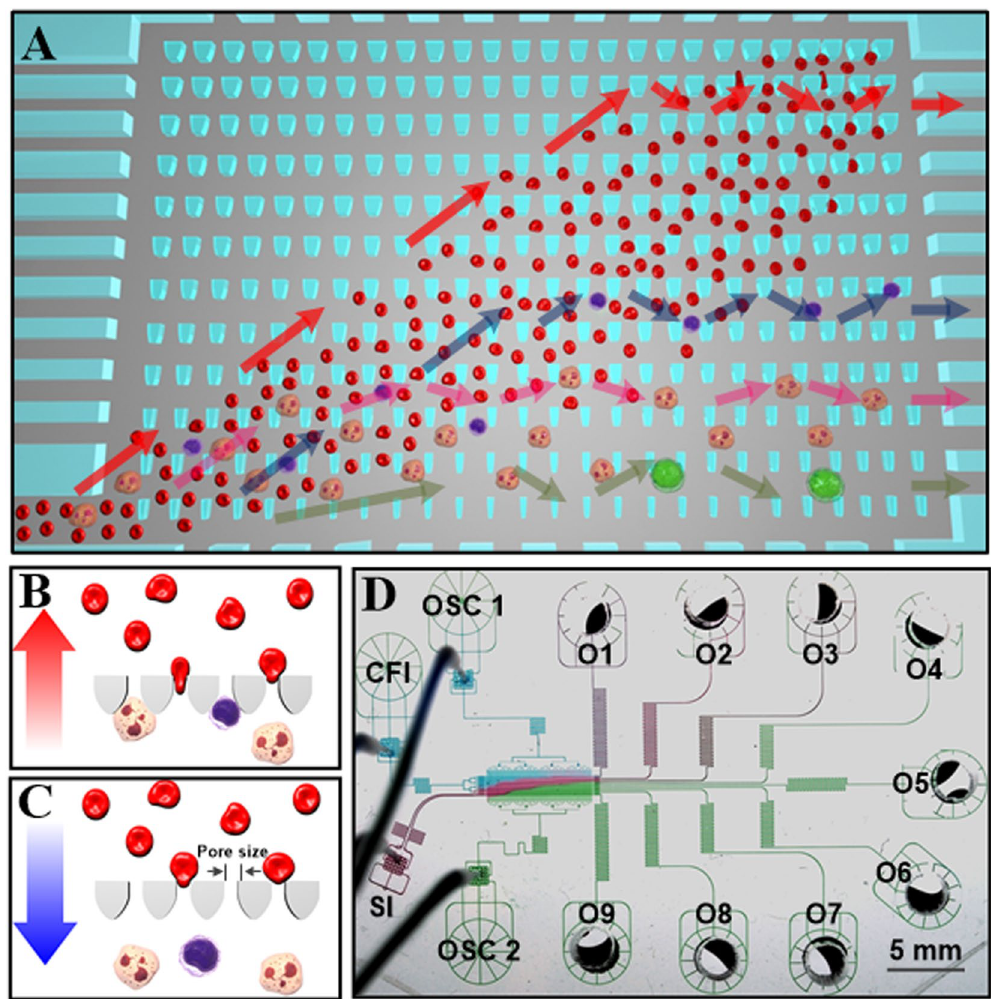
Figure 1. Principle and design of the microfluidic ratchet cell sorting device. ( A ) Schematic illustration of the cell sorting region consisting of a 2D array of funnel microstructures with progressively smaller pore sizes from the bottom to the top row. Unprocessed whole blood is introduced at the bottom-left corner of the array while cells flow along a diagonal path under a combined biased oscillatory flow and cross flow. Smaller and softer RBCs flow into the outlets lining the top of the sorting region while the flow of leukocytes is restricted based on their size and deformability, which divert each cell into specific outlets. Colored arrows indicate the ratchet motions of erythrocytes and different subsets of leukocytes. ( B , C ) The underlying principle of the microfluidic ratchet involves selectively transporting cells using a ratcheting effect. Smaller and more deformable cells flow across tapered constrictions during forward flow and are prevented from returning during reverse flow. Larger and less deformable cells are trapped by the constriction and released with each reverse flow. ( D ) Image of the microfluidic device infused with different food color dyes illustrating components of the microfluidic device including the sorting region, sample inlet (SI), cross-flow inlet (CFI), oscillatory flow inlets (OSC1 and OSC2), and nine outlets